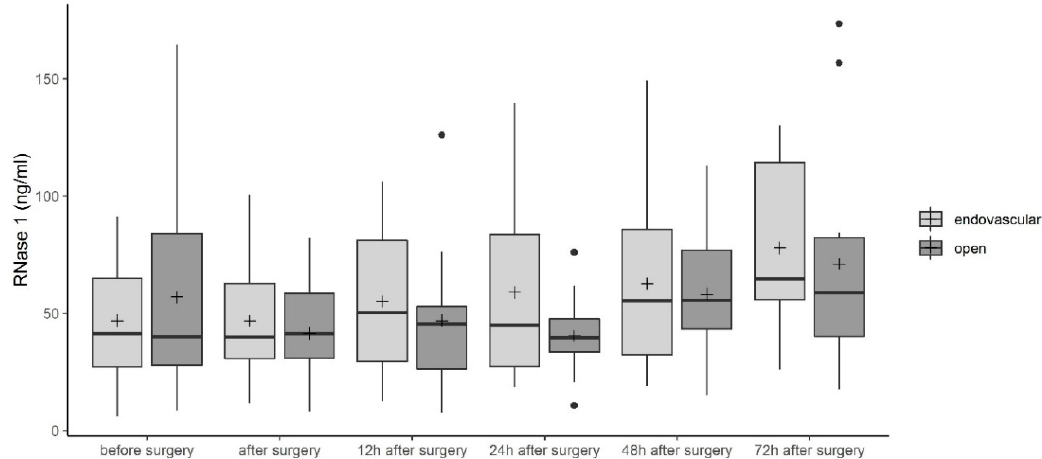
Figure 2. Ribonuclease (RNase) 1 serum levels in patients undergoing open or endovascular thoracoabdominal aortic aneurysm (TAAA) repair. Data are presented as box-whisker plots. Lines inside the boxes represent the median and the pluses represent the mean. The box is defined by Q1 and Q3. The whiskers range from Q1 to Q1 + 1.5 ∗ (Q3 − Q1) and Q3 to Q3 − 1.5 ∗ (Q3 − Q1), with observations outside of the whiskers shown as points classified as outliers. Unpaired t-test (two-tailed) was used for statistical analysis of the two groups. RNase 1, ribonuclease 1.